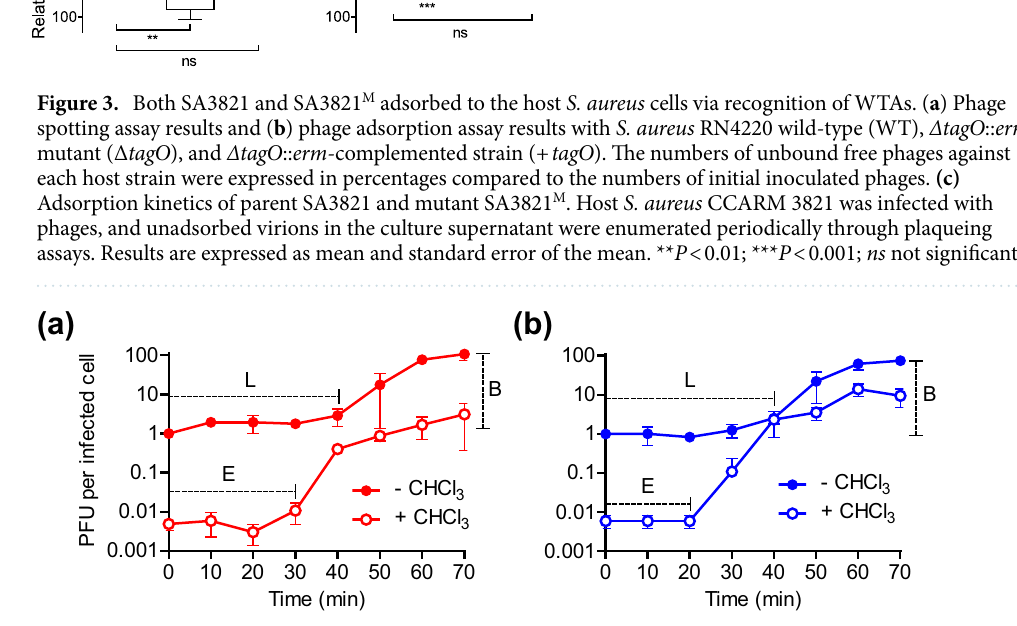
Figure 4. One-step growth curves for ( a ) parent SA3821 and ( b ) mutant SA3821 M . The replicative characteristics (i.e., E, eclipse period in min; L, latent period in min; and B, burst size in PFU/infected cell) of each phage were determined during one round of phage propagation in single S. aureus CCARM 3821 cells. Biological three independent experiments were conducted and the mean and s.d. are shown. CHCl 3 ;